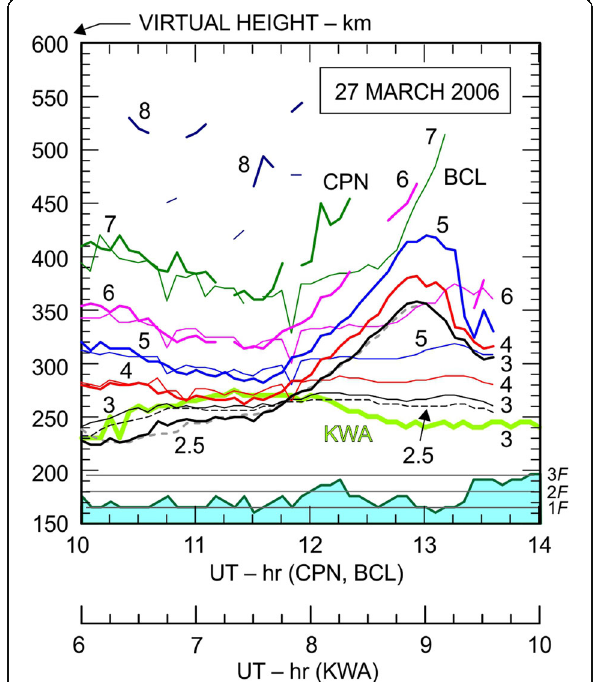
Fig. 11 Composite plot of h ’ f versus UT. (a) Bold lines are for CPN. (b) Thin lines are for BCL. (c) Dashed lines are for h ’ F (2.5 MHz). The occurrence of the highest order n F in ionograms are indicated by the blue-filled curve at the bottom of the figure. Three horizontal lines are shown to indicate presence of the 1 F , 2 F and 3 F